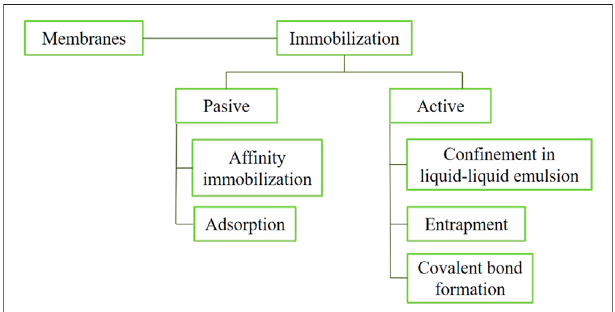
FIGURE 2 | Approaches to increase the biomass concentration in